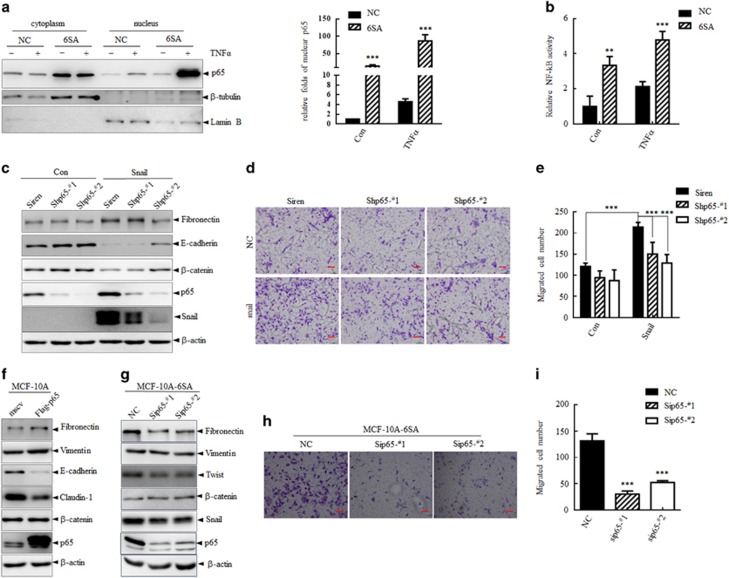
Accumulation of p65 facilitates EMT program. (a) MCF-10A-NC and MCF-10A-6SA cells were treated with TNFα (10 ng/ml) for 45 min followed by nuclear fractionation analysis with immunoblots. Lamin B and β-tubulin served as internal control for nucleus and cytoplasm, respectively (left). Right: quantification analysis of band density of nuclear p65 by ImageJ and normalized to that of lamin B. ***P<0.001 as compared with MCF-10A-NC cells in each group. (b) MCF-10A-NC and MCF-10A-6SA cells were transfected with luciferase reporter vector driven by six repeated κB reaction elements followed by TNFα stimulation and the transcriptional activity was determined by measuring the luciferase activity. **P<0.01 and ***P<0.001 as compared with MCF-10A-NC cells in each group. (c-e) MCF-10A cells were stably infected with Siren empty vector or two shRNAs targeting p65 followed by EMT induction with Snail overexpression. (c) Immunoblots for indicated proteins. (d) Cell migration ability were analyzed with Transwell assay. Representative images were shown in d, Scale bar represents 20 μm. (e) Quantitative analysis of the migrated cell numbers in five different fields. ***P<0.001. (f) MCF-10A cells were stably infected with pMSCV empty vector or Flag-p65 overexpression vector. Cell lysates were analyzed with indicated proteins by immunoblots. (g–i) 10A-6SA cells were transfected with siNC or siRNAs targeting p65. (g) Immunoblots analysis of indicated proteins. (h) Migration ability of siNC and sip65 cells were analyzed by Transwell assay. Representative images of migrated cells were shown in h, Scale bar represents 20 μm. (i) Quantitative analysis of the migrated cell numbers in five different fields. ***P<0.001 as compared with siNC cells.